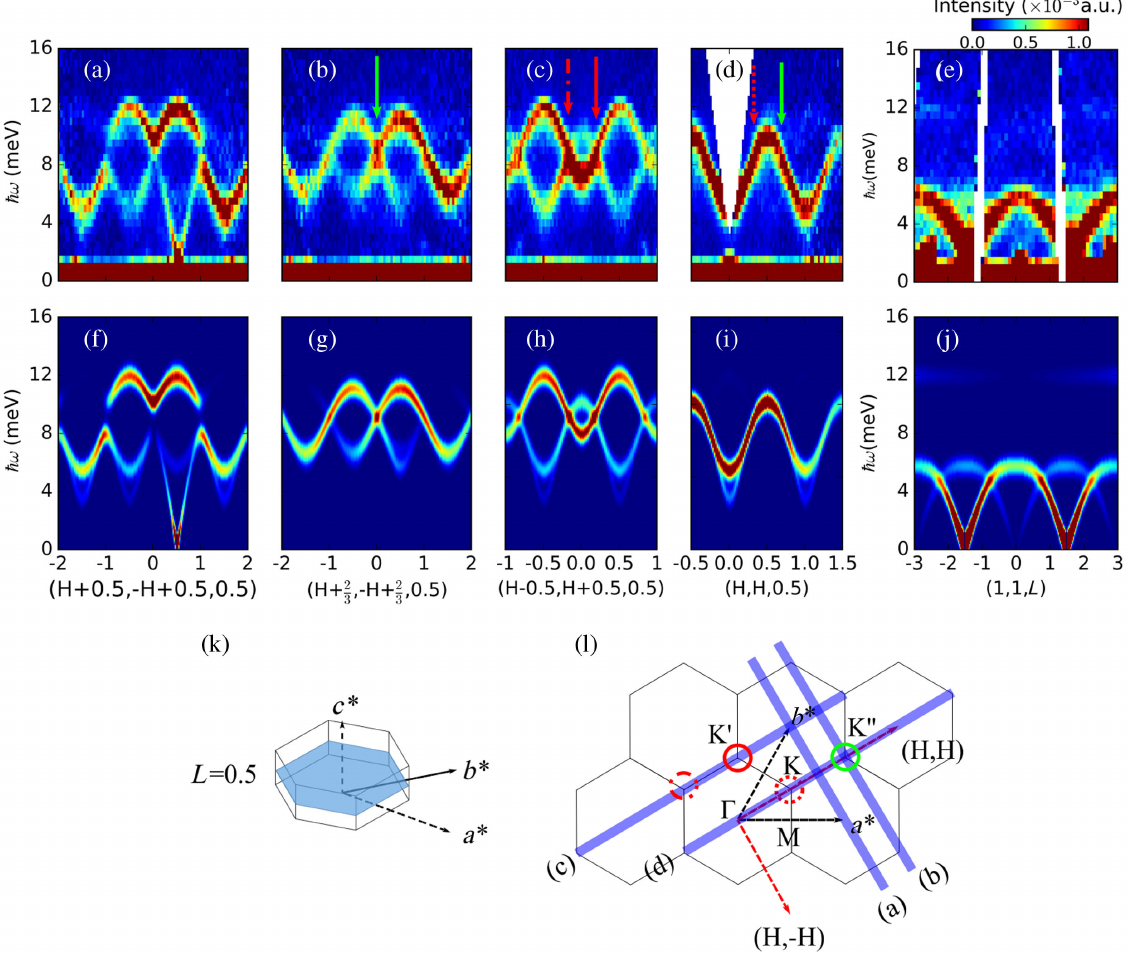
FIG. 3. (a) – (e) Momentum- and energy-resolved neutron scattering intensity map of magnons in CoTiO 3 . The data were obtained at ¼ 50 meV at SEQUOIA at the Spallation Neutron Source (SNS). A pseudocolor intensity T ¼ 5 K, with an incident neutron energy E i scale, where red (blue) denotes large (small) scattering intensity, is used to plot the data. Panels (a) – (d) show magnon excitations along ( H; (cid:3) H) and ( H; H ) within the honeycomb plane at fixed L ¼ 0 . 5 , while panel (e) shows excitations along L for fixed in-plane ¼ − 4 . 41 meV, J ¼ 0 meV, and J ¼ J ¼ 0 . 57 meV after momentum (1,1). (f) – (j) Calculated magnon spectra using J k ⊥ ; 1 k ; 2 0 ¼ 2 00 ⊥ ; 2 0 ¼ 2 00 ; 1 convolving with the experimental energy resolution of 1 meV using spinW [37]. (k) Schematics of the 3D BZ and (l) projection of 3D reciprocal space onto the 2D honeycomb plane. The L ¼ 0 . 5 plane has been shaded in blue in panel (k). Directions of momentum transfers within the L ¼ 0 . 5 plane in panels (a) to (d) are denoted by thick blue lines in panel (l). Circles in panel (l) indicate positions of the Dirac point where magnon bands cross, which are denoted by arrows in panels (b) – (d). Circles and arrows of the same line style and color are used for the same Dirac